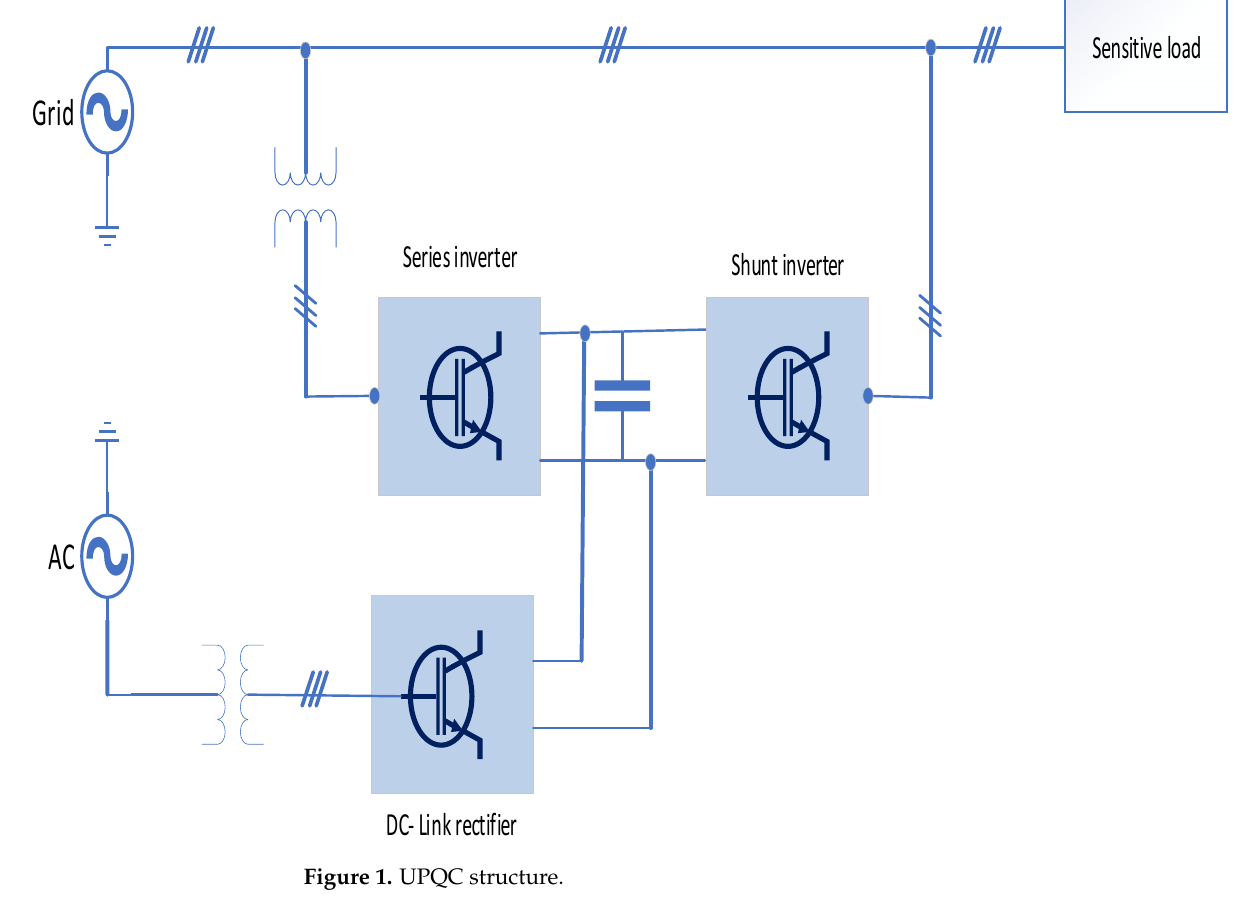
Figure 1. UPQC structure.